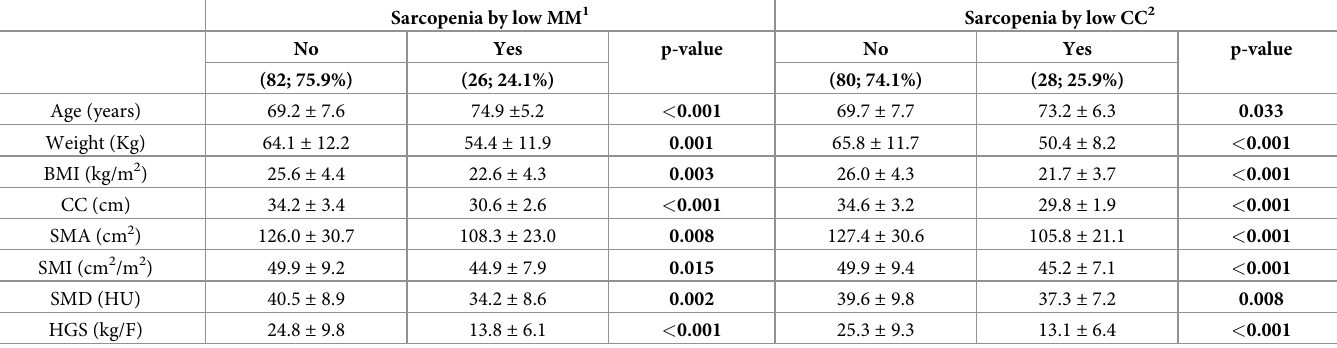
Table 2. Frequency of sarcopenia and comparison of quantitative variables in patients classified with sarcopenia according to the different criteria (n =